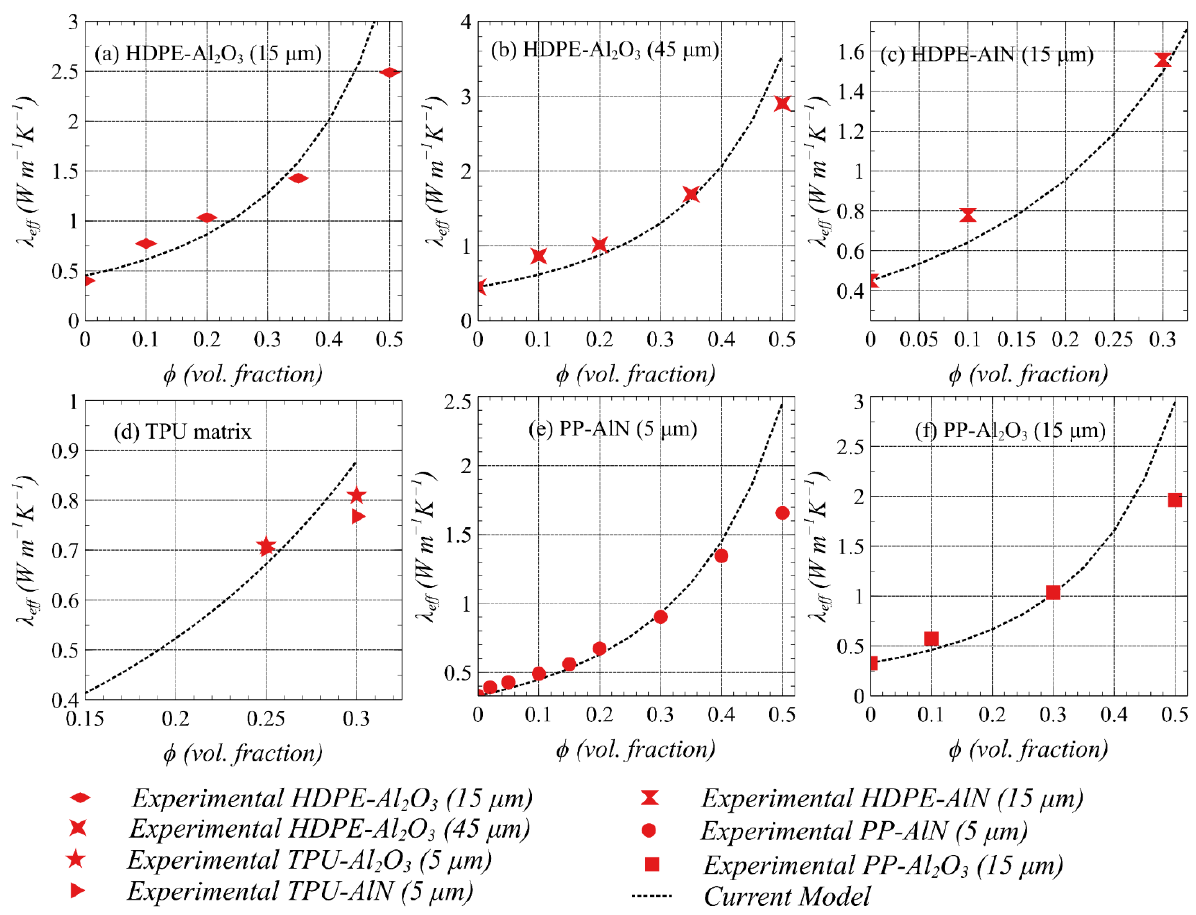
Figure 8. The measured and predicted thermal conductivity of different type filler and matrix composites as a function of filler loading. ( a ) HDPE/Al 2 O 3 composites with 15 µm Al 2 O 3 . ( b ) HDPE/Al 2 O 3 composites with 45 µm Al 2 O 3 . ( c ) HDPE/AlN composites with 15 µm AlN. ( d ) TPU with AlN and Al 2 O 3 composites with 5 µm filler. ( e ) PP/AlN composites with 5 µm AlN. ( f ) PP/Al 2 O 3 composites with 15 µm Al 2 O 3 .